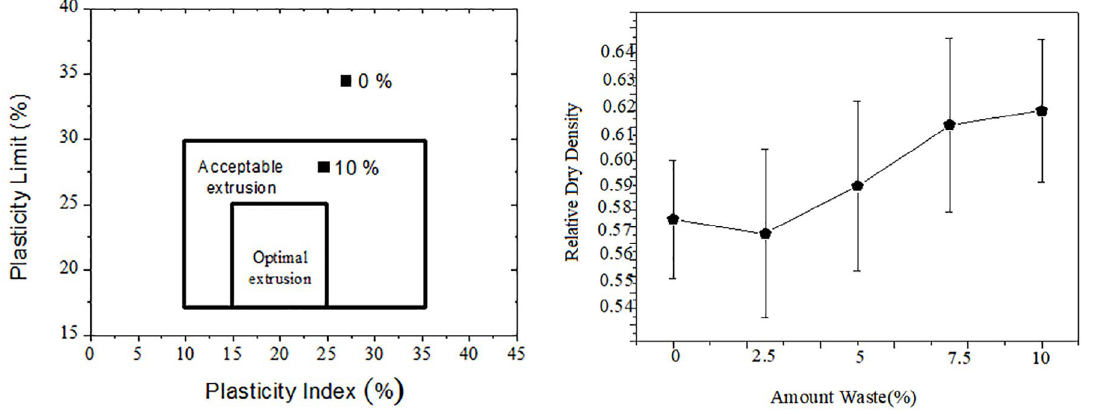
Figure 7. Apparent density of the different ceramic compositions. Figure 5. Plasticity index in the Atterberg diagram for plain and